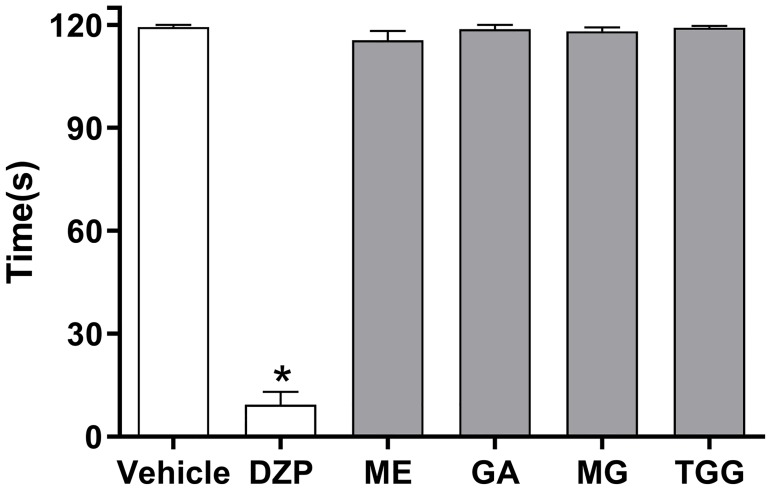
Effects of ME, gallic acid, methyl gallate and 1,2,6-tri-O-galloyl-β-d-glucopyranose from D. vandellianum on motor function in mice.Bar graph representing the run time on the rotarod, 40 min after intraplantar injection of ME (200 mg/kg), gallic acid (GA; 200 mg/kg), methyl gallate (MG; 200 mg/kg), 1,2,6-tri-O-galloyl-β-d-glucopyranose (TGG; 200 mg/kg), diazepam (DZP; 10 mg/kg, reference drug) or vehicle (saline; control group). Data are reported as means ± SEM; n = 6 mice per group. * Significantly different from the vehicle group (p < 0.001). One-way ANOVA followed by the Tukey’s test.